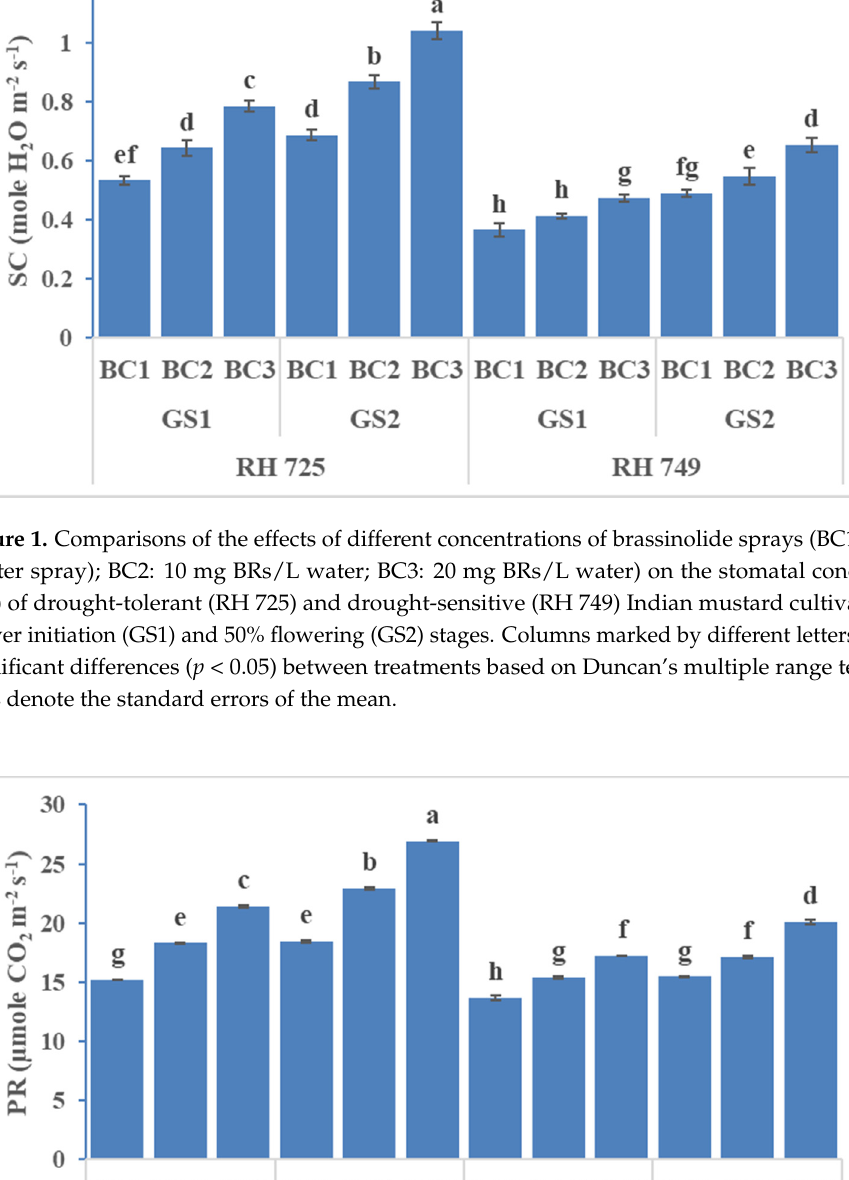
Figure 3. Comparisons of the effects of different concentrations of brassinolide sprays (BC1: control (water spray); BC2: 10 mg BRs/L water; BC3: 20 mg BRs/L water) on the transpiration rate (TR) of drought-tolerant (RH 725) and drought-sensitive (RH 749) Indian mustard cultivars at the flower initiation (GS1) and 50% flowering (GS2) stages. Columns marked by different letters indicate sig- nificant differences ( p < 0.05) between treatments based on Duncan’s multiple range test. Error bars denote the standard errors of the mean. 3.2. Oxidative Stress Indicators Three-way ANOVA (Table 1) showed highly significant effects of all the three indi- vidual factors and their interactions on oxidative stress indicators, except that C × BC and C × GS × BC were insignificant for malondialdehyde, while GS × BC and C × GS × BC were insignificant for electrolyte leakage. Figures 4–6 show that brassinolide treatments significantly decreased the oxidative stress indicators—i.e., hydrogen peroxide (H 2 O 2 ),